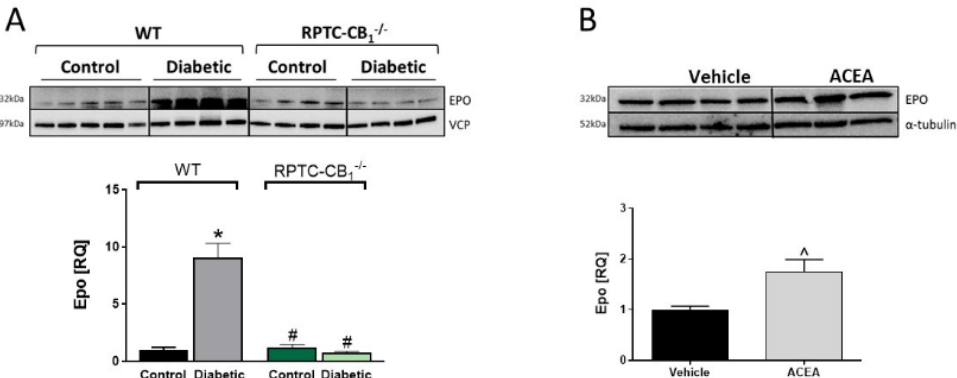
Figure 5. Renal EPO levels are elevated during diabetes or by activation of CB 1 R. Representative Western blots and quantification of the protein levels of EPO in kidney samples collected from normal and diabetic WT and RPTC-CB 1 − / − mice ( A ), representative Western blots and quantification of renal protein levels of EPO in mice treated acutely with arachidonyl-2 ′ -chloroethylamide (ACEA) (10 mg/kg, IP; B ). Data represent the mean ± SEM from 8–13 animals per group, * p < 0.05 vs. non-diabetic control WT mice, # p < 0.05 vs. diabetic WT mice, ˆ p < 0.05 vs. vehicle-treated mice.